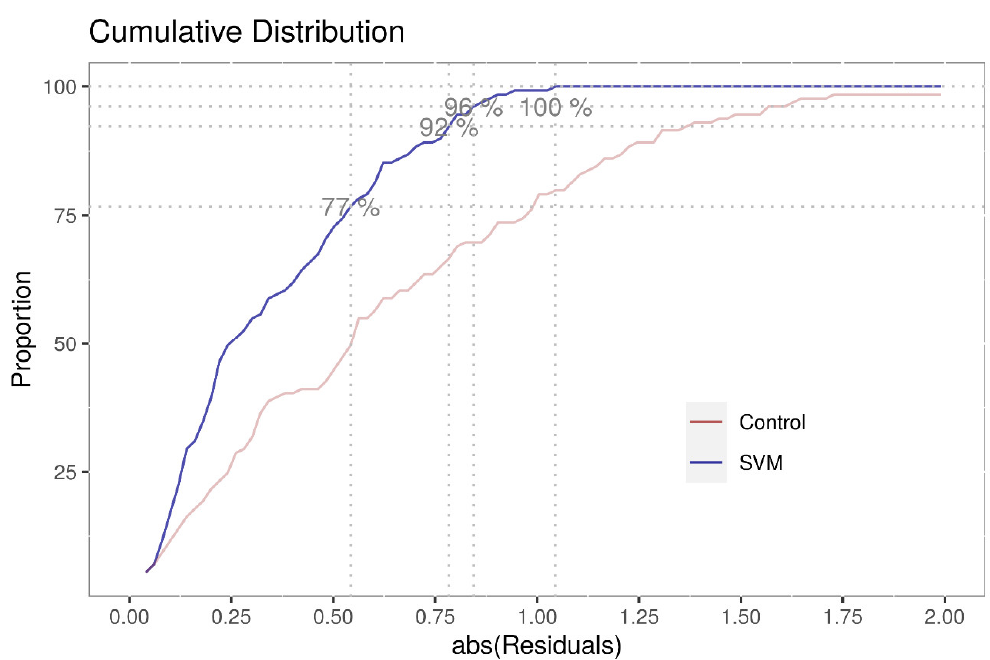
Figure 6. Cumulative distribution of the percentage of success of the model versus allowed error.